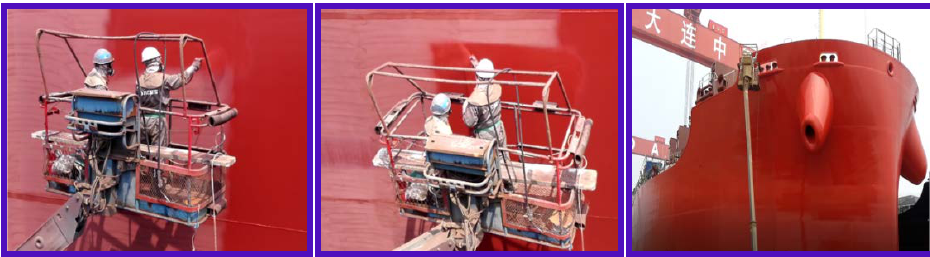
Figure 2. Chinese shipyard painters work at height to paint up-close.